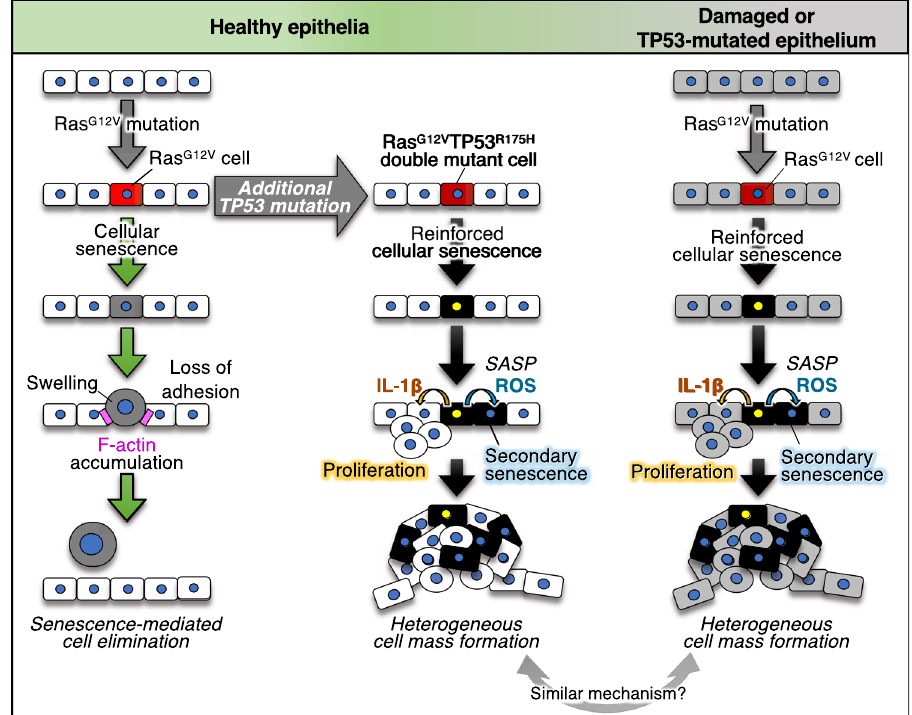
Fig. 7 Schematic illustration of the roles and regulation of cellular senescence during primary tumorigenesis. A newly emerged oncogenic cell becomes senescent and is eliminated from the epithelia. Additional TP53 mutation and tissue damage switches oncogene-induced senescence from suppressor to driver during primary